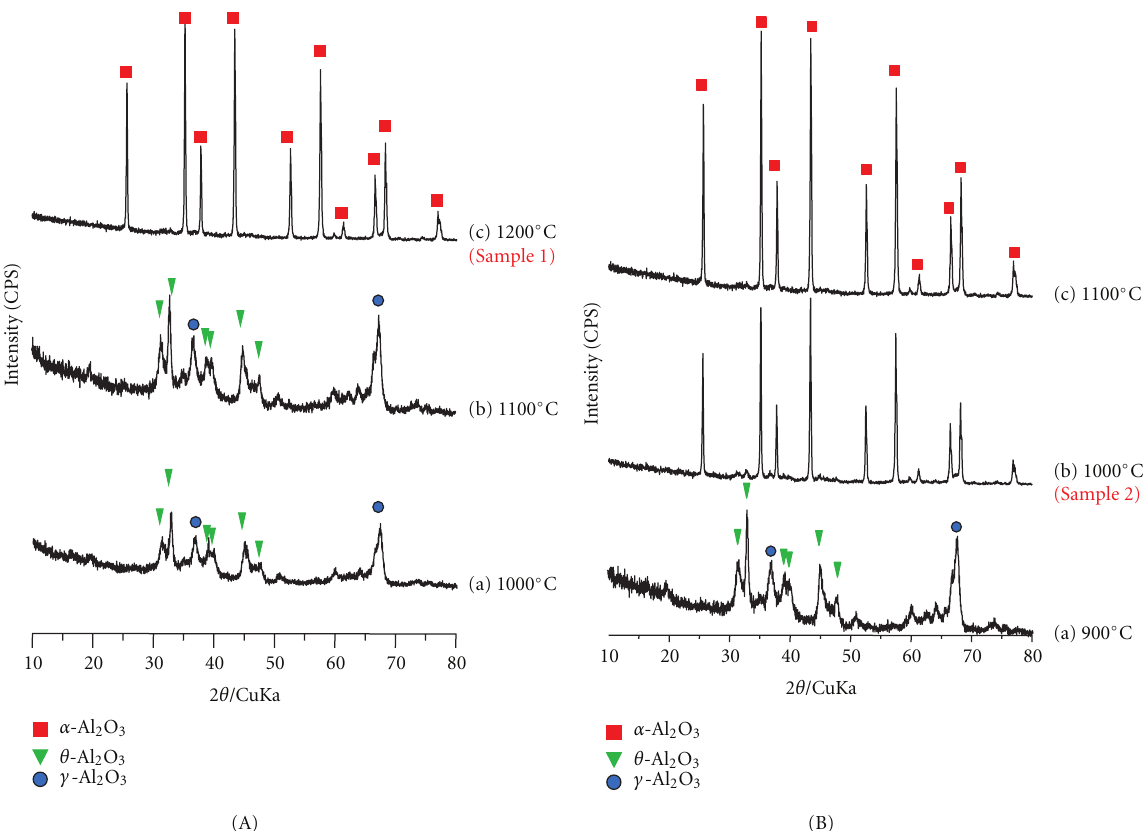
Figure 2: The XRD patterns of the alumina phases prepared with and without microwave pretreatment according to calcinations temperatures. (A) without microwave pretreatment and (B) with microwave pretreatment.